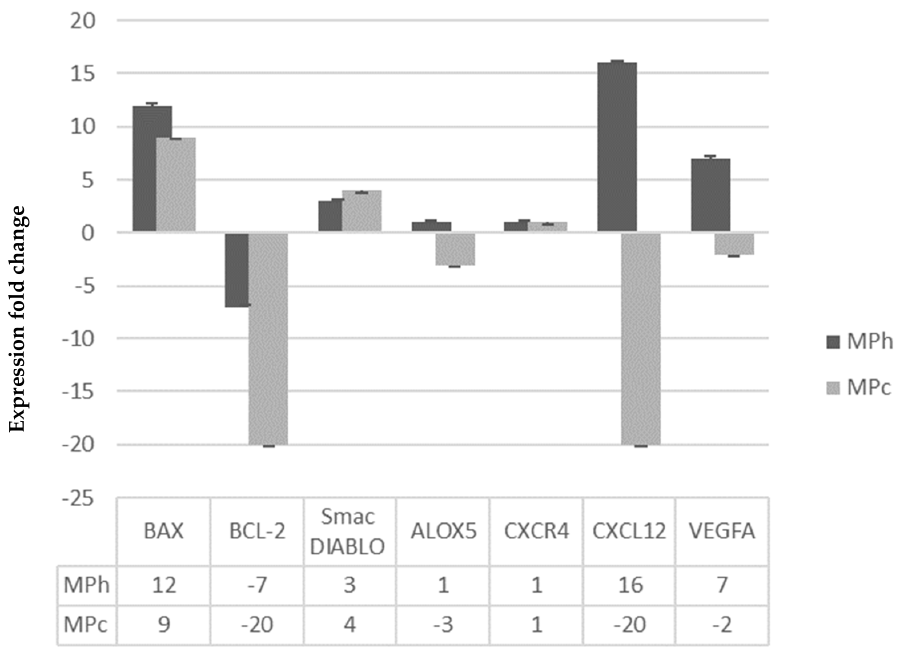
Figure 5. Modulation of mRNA gene expression in PC3 cells treated with MNTC of the active plant extracts of Marantodes pumilum after 96 h. The expression fold change was determined as described in RT-qPCR conditions and analysis. Data are means ± SD; n = 4.